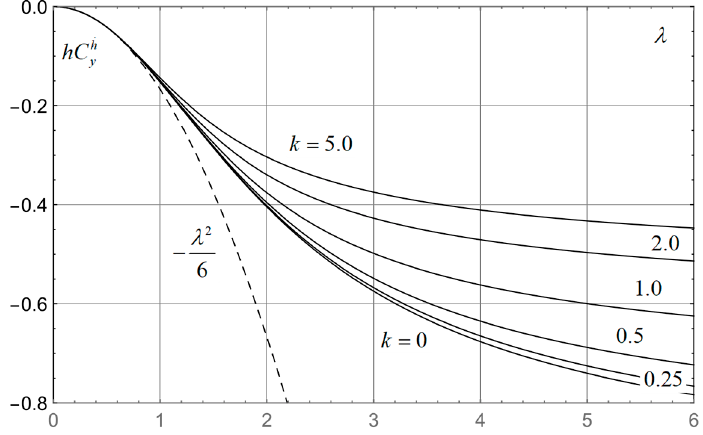
. h Figure 2. Derivative hC y for a rectangular wing in extreme ground effect versus aspect ratio for hC  for a rectangular wing in extreme ground effect versus aspect ratio for Figure 2. Derivative h y different Strouhal numbers. different Strouhal numbers.